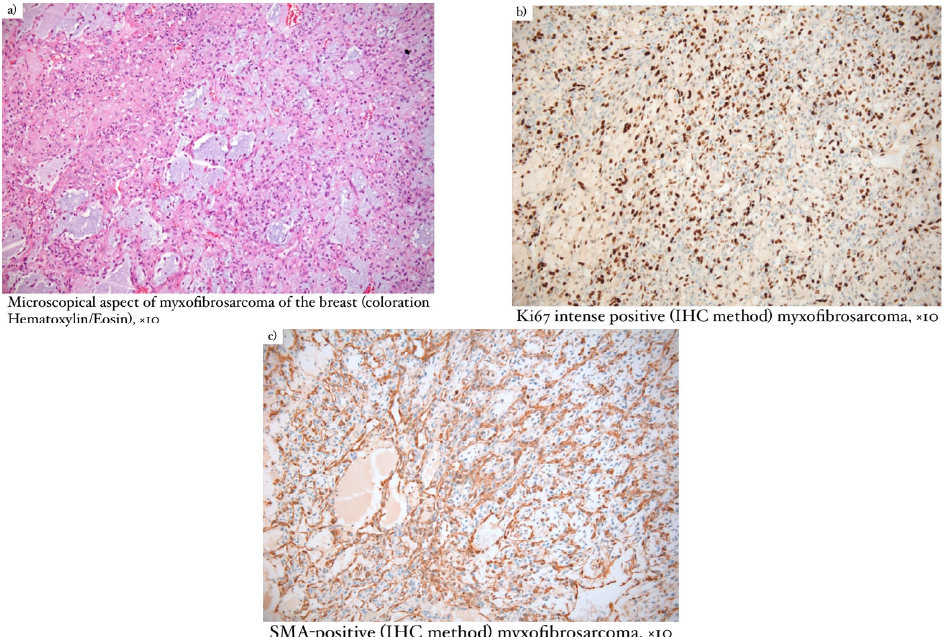
Figure 2. ( a ) Microscopical aspect of myxofibrosarcoma of the breast (coloration Hematoxylin/Eosin), ×10; ( b ) Ki67 intense positive (IHC method) myxofibrosarcoma, ×10; ( c ) SMA–positive (IHC method) myxofibrosarcoma, ×10.